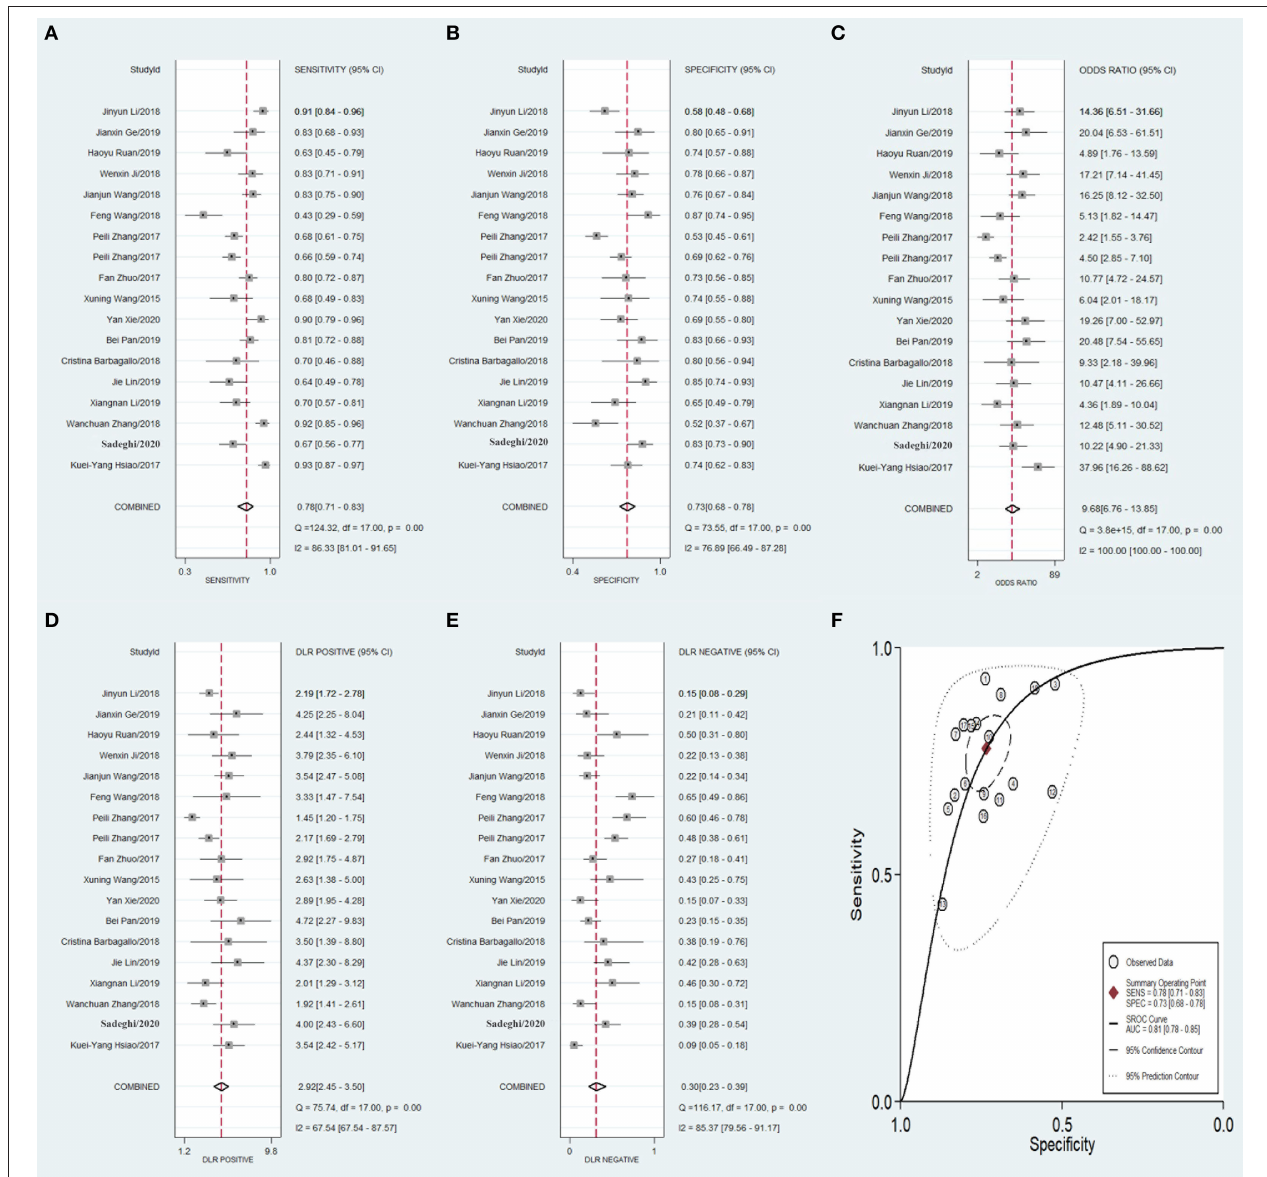
FIGURE 3 | Forest plots of pooled diagnostic power of circRNA as a biomarker for colorectal cancer among 18 articles, (A) Sensitivity, (B) Specificity; (C) DOR; (D) PLR; (E) NLR and (F) AUC. DOR, diagnostics odds ratio; PLR, positive likelihood ratio; NLR, negative likelihood ratio; AUC, the area under receiver operating characteristics